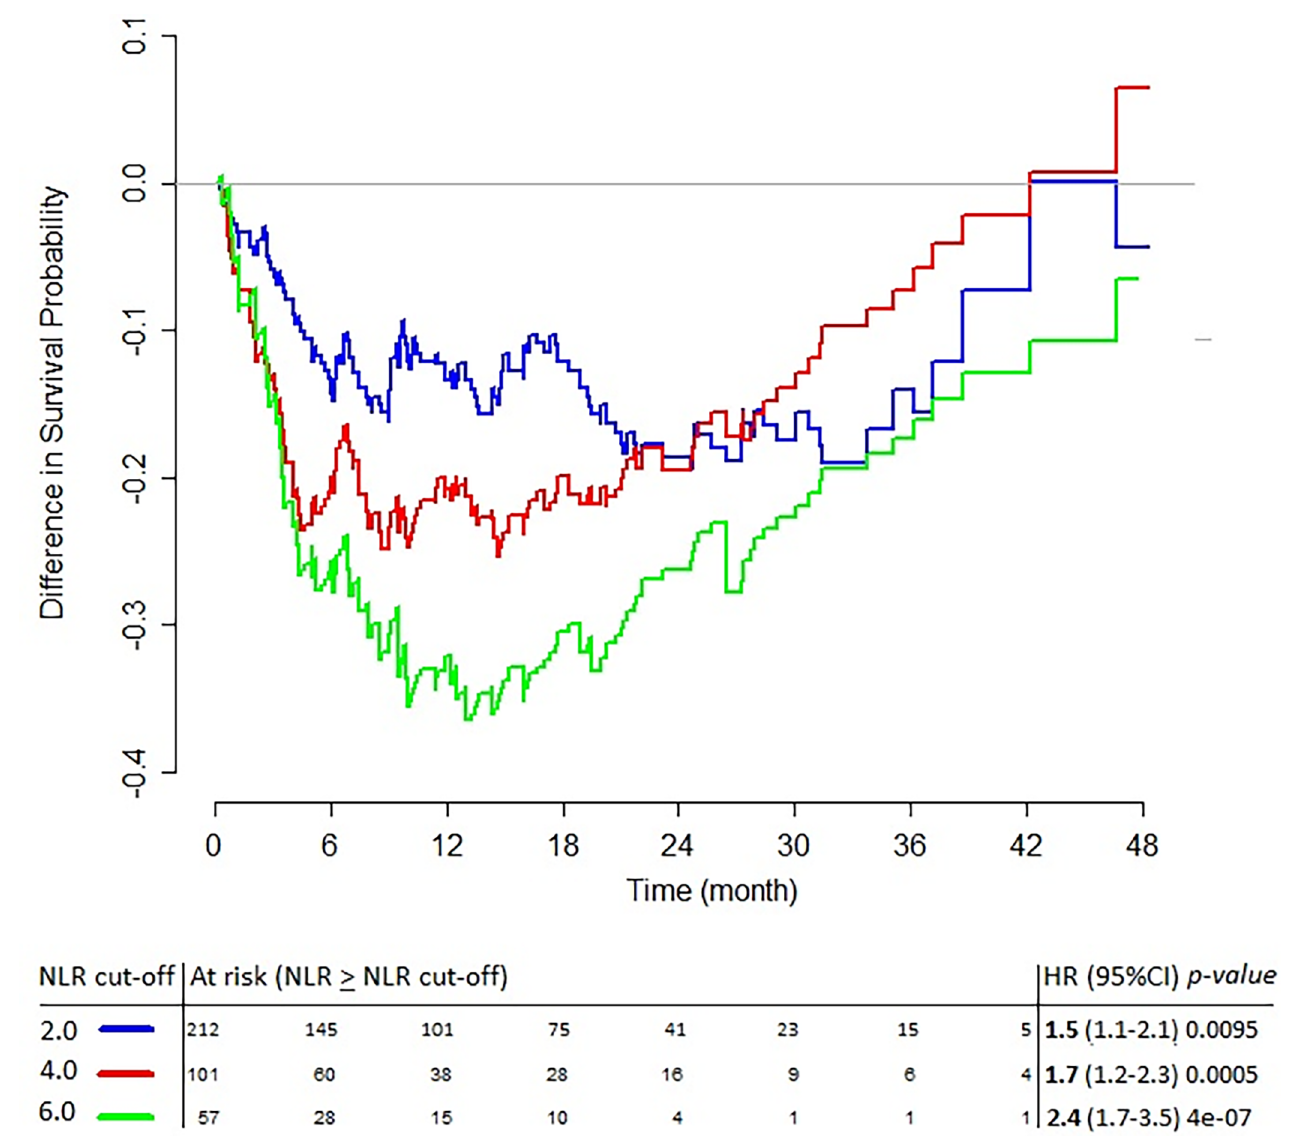
Fig 1. Survival probability for patients with a neutrophil-to-lymphocyte ratio (NLR) at the cut-off value or higher versus below the cut-off value for each unit variation of NLR cut-off (Cox univariate model).